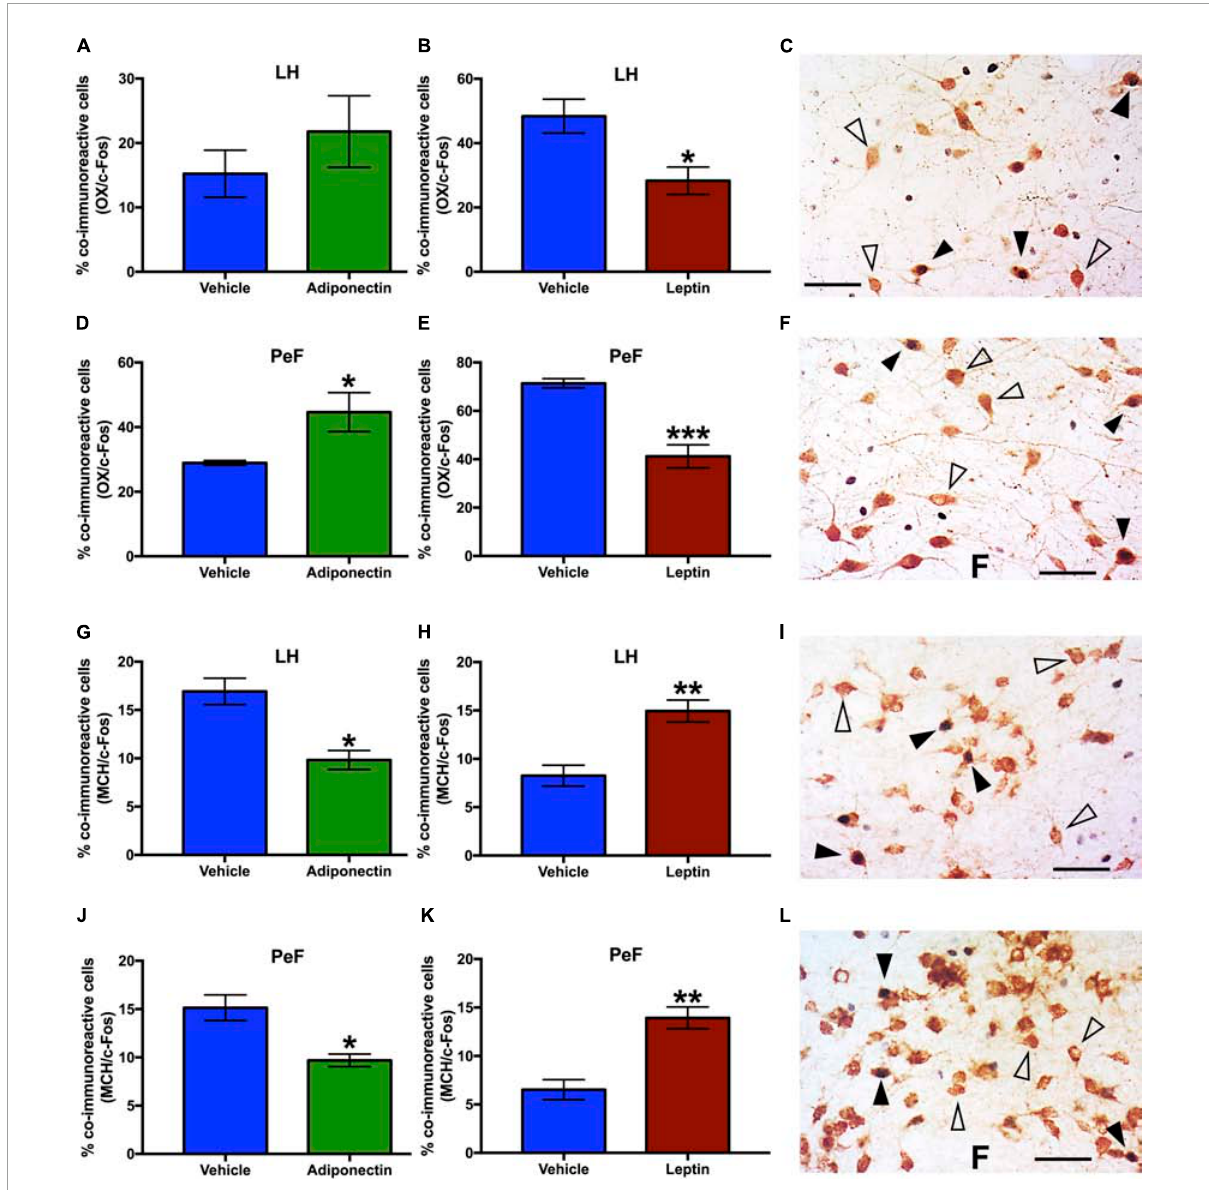
FIGURE8 OX-c-Fos and MCH-c-Fos co-immunoreactivity in LH and PeF nuclei after adipokines or vehicle administration. Percentage of OX/c-Fos co-expression in (A–C) LH and (D–F) PeF area 2 h after adiponectin or leptin administration, respectively. Percentage of MCH/c-Fos co-expression in (G–I) LH or (J–L) PeF area 2 h after adiponectin or leptin administration, respectively. Representative images from the double immunoreactivity are shown in the right panels (C,F,I,L) . Open triangles, OX or MCH neurons, black triangles, OX/c-Fos or MCH/c-Fos co-immunoreactivity, and black arrow c-Fos immunoreactive cells. Adipokines vs. vehicle * P < 0.05, ** P < 0.01, *** P < 0.001. OX, Orexin; MCH, melanocortin; LH, lateral hypothalamus nucleus; PeF, perifornical